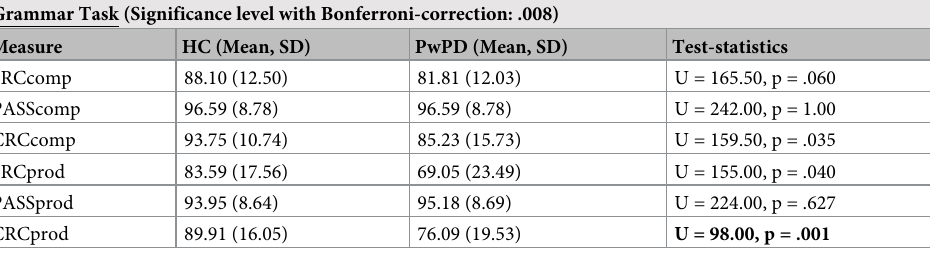
Table 4. Summary of group comparisons for the error rate in the grammar tasks providing descriptive data as well as statistical results. Higher scores indicate better performance. Results significant with Bonferroni corrections are marked in